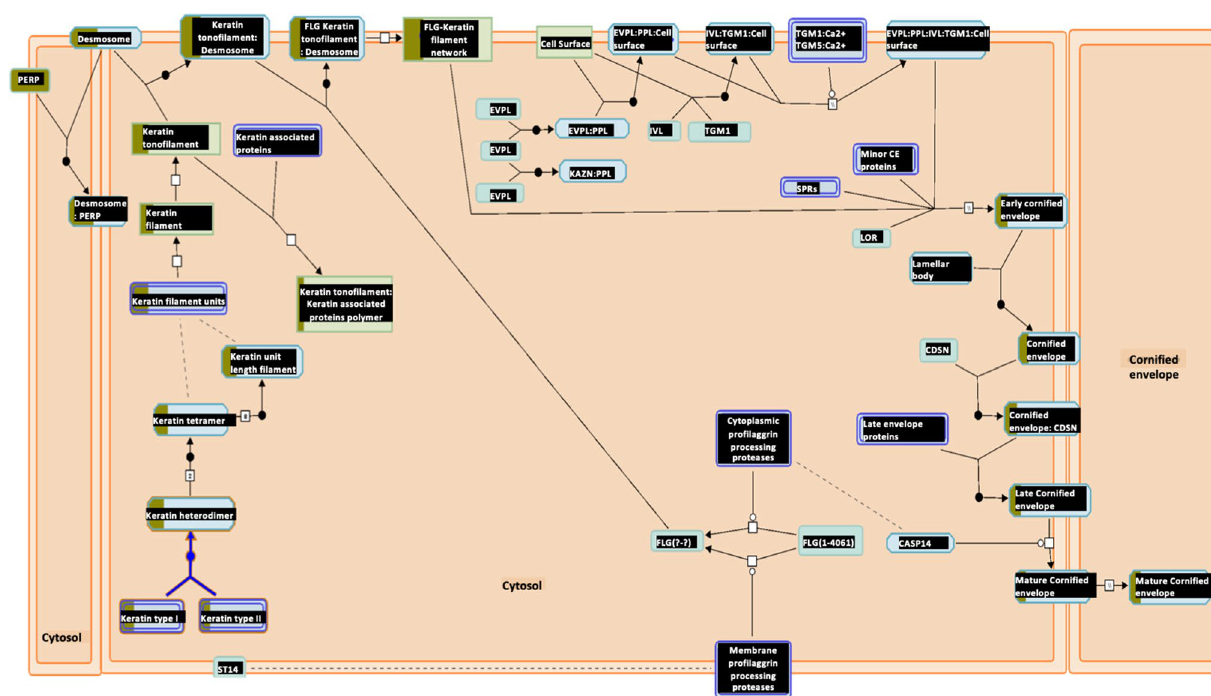
Figure 7. Keratinization pathway is upregulated in LUSC 28 . The Keratinization pathway is the most upregulated pathway according to Reactome analysis with p-value 3.33E−15 and FDR 1.95E−12. The boxes partially highlighted in brown indicate the number of genes identified in the analysis that are associated with each